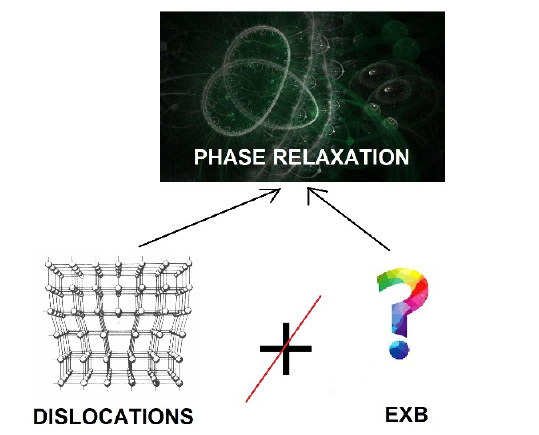
Figure 26 . Two possible sources for phase relaxation. 1) the presence and proliferation of topo- logical defects, such as dislocations, as contemplated in [4]. 2) the interplay between spontaneous and explicit breaking of the symmetry, observed in the holographic models [26, 29, 34, 35]. The microscopic mechanism and the hydrodynamic description of the second scenario are still